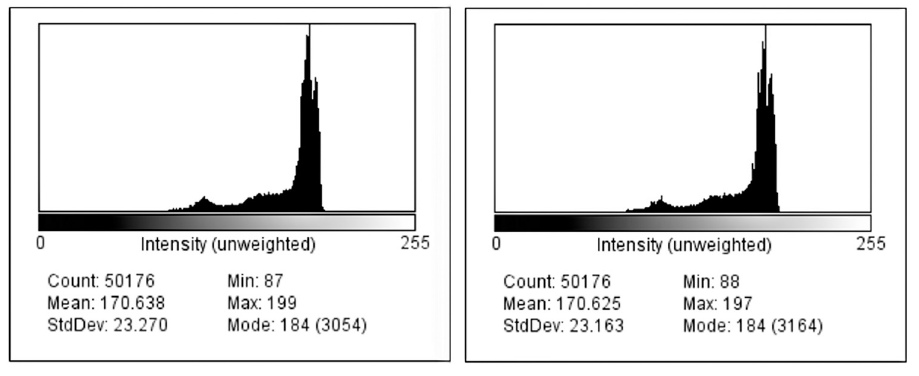
Fig 19. Histograms of original image vs box blur